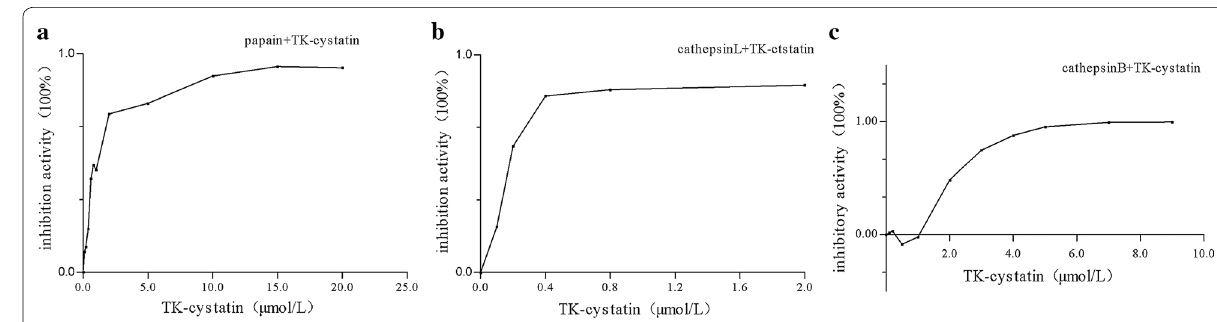
Fig. 8 Inhibitory activity of TK-cystatin against three cysteine proteases. Inhibitory activity of TK-cystatin against papain ( a ) and cathepsin L ( b ) and cathepsin B ( c ). The activity of non-inhibited enzyme (incubated without TK-cystatin) was taken as 100% activity (Inhibitory activity: 0%). Data shown were the average of three experiments